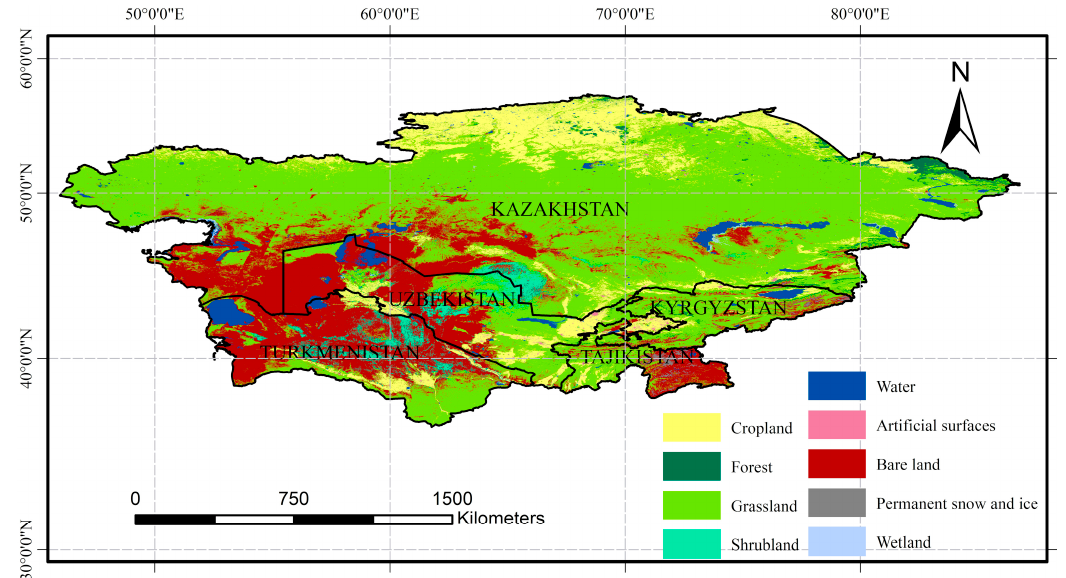
Figure 10. Results of integration of multi-source landcover products in Central Asian study area.